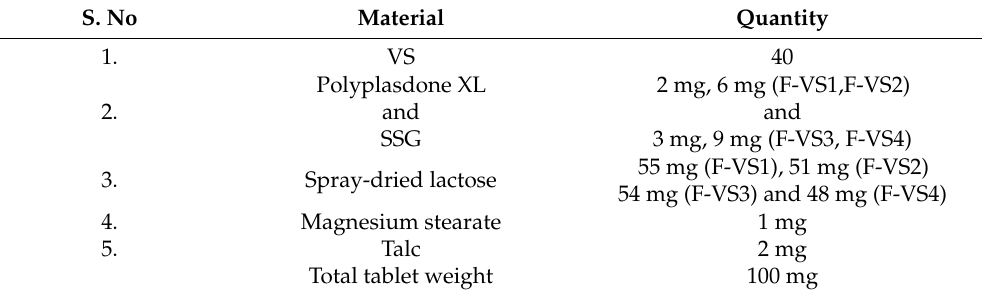
Table 9. Composition of